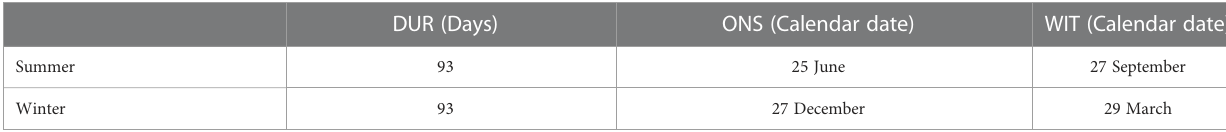
TABLE 1 Climatological length and timing indices in the Bohai Sea including duration (DUR), onset (ONS) and withdrawal (WIT) averaged over the period of 1982 – 2019 for the summer and winter seasons, respectively.